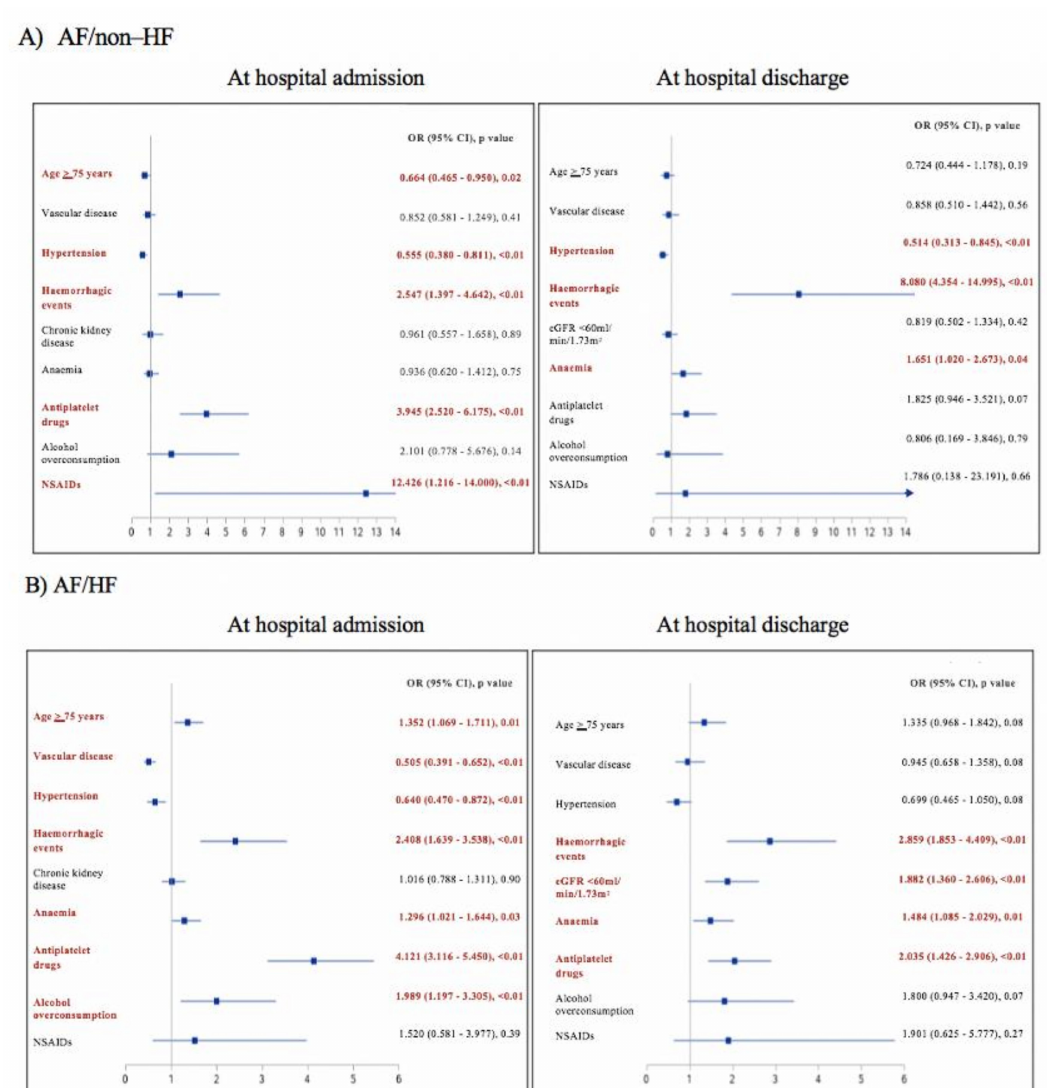
Figure 3. Predictors of non-prescription of oral anticoagulation in atrial fibrillation patients without heart failure ( A ) and with heart failure ( B ). Following variables were included in analysis: age ≥ 75 years, female sex (vs male), LV EF < 50% (for the AF/HF group), hypertension, vascular disease (including those hospitalized for acute coronary syndrome for the analysis at discharge), diabetes, previous stroke, previous hemorrhagic events, renal dysfunction (chronic kidney dysfunction for the analysis at hospital admission, and GFR < 60 mL/min/1.73 m 2 for the analysis at discharge), liver disease, anemia (hemoglobin < 12 g/dL for women and <13 g/dL for men), antiplatelet therapy (at hospital admission and at hospital discharge for admission and discharge analyses, respectively), alcohol overconsumption and chronic treatment with NSAIDs. Abbreviations: See Table 1; CI, coincidence interval; NSAIDs, non-steroidal anti-inflammatory drugs; OR, odds